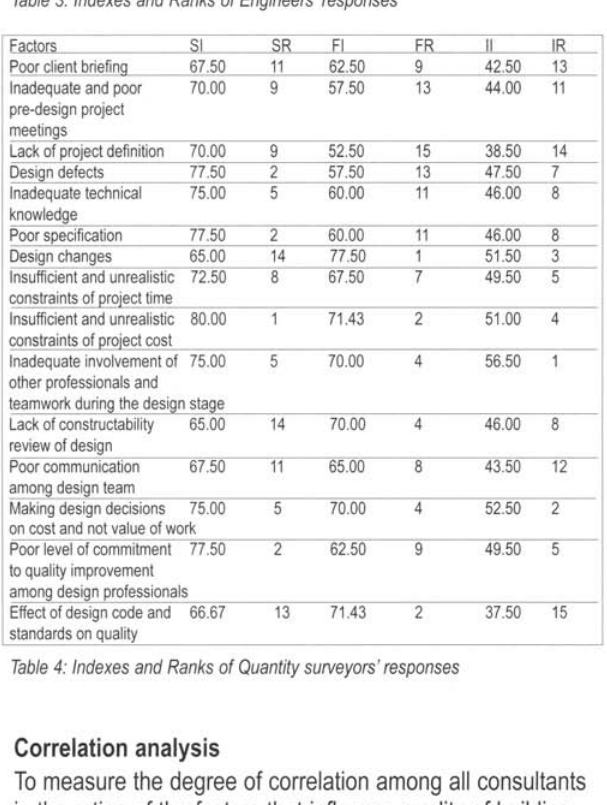
Correlation analysis